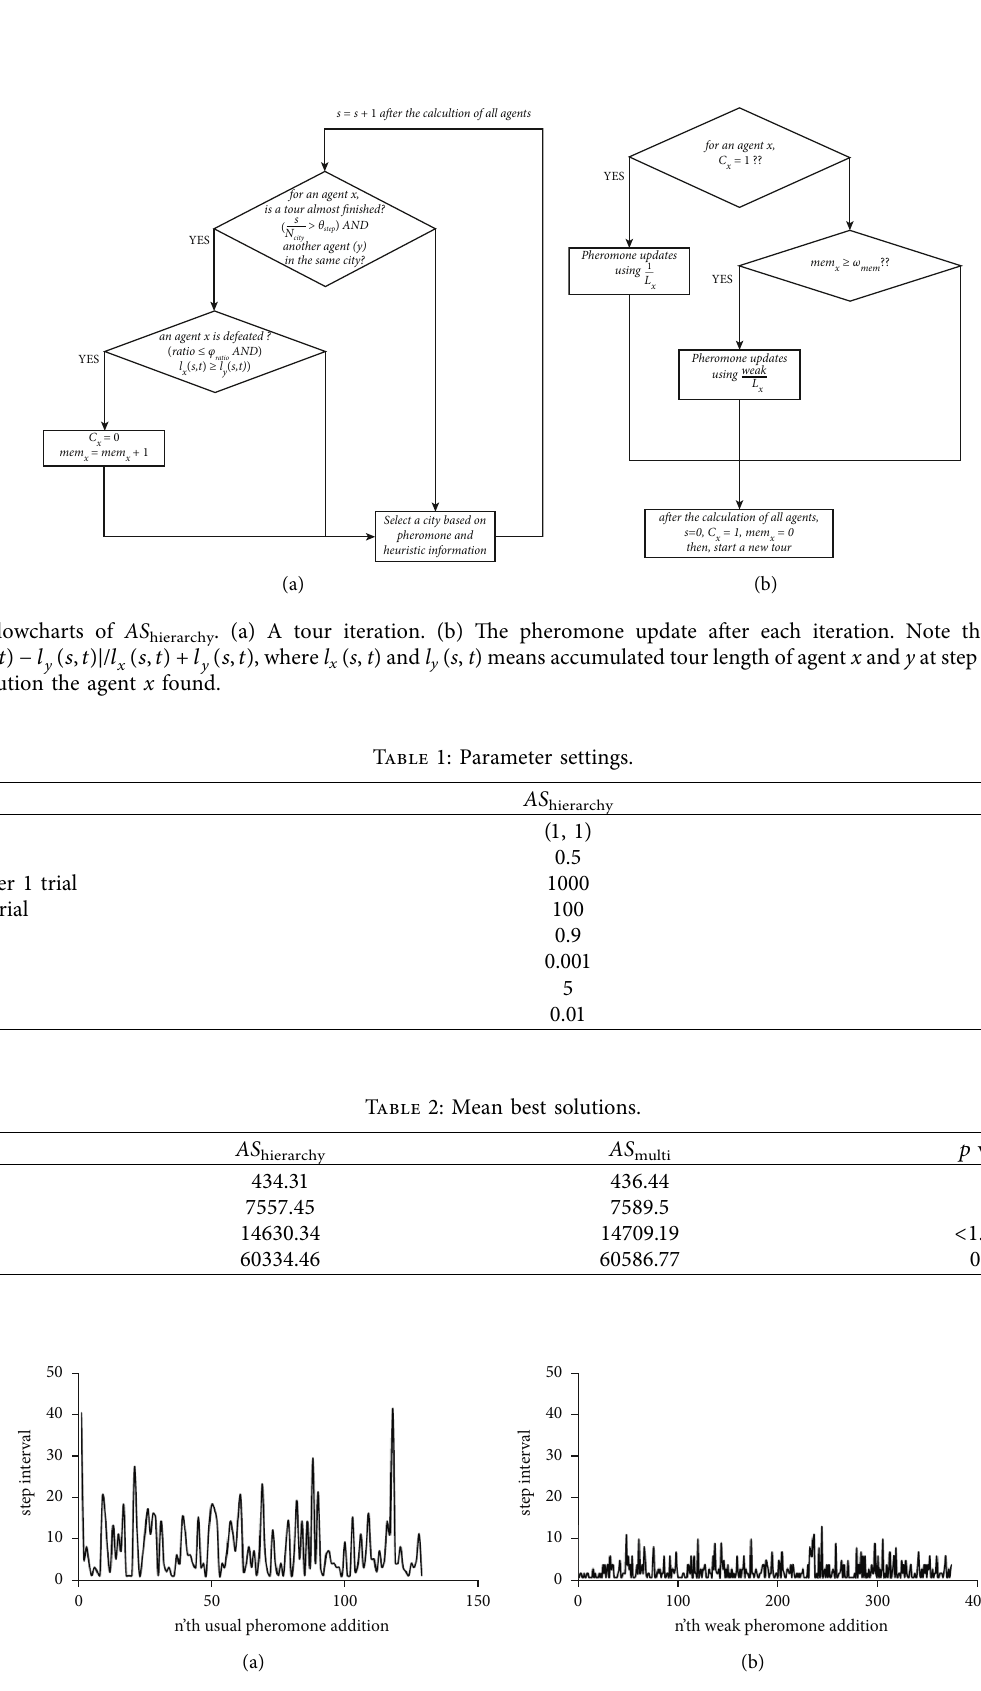
Figure 2: Step interval of pheromone addition ( Eil 51). (a) The step interval of the usual pheromone addition. (b) The step interval of weak pheromone